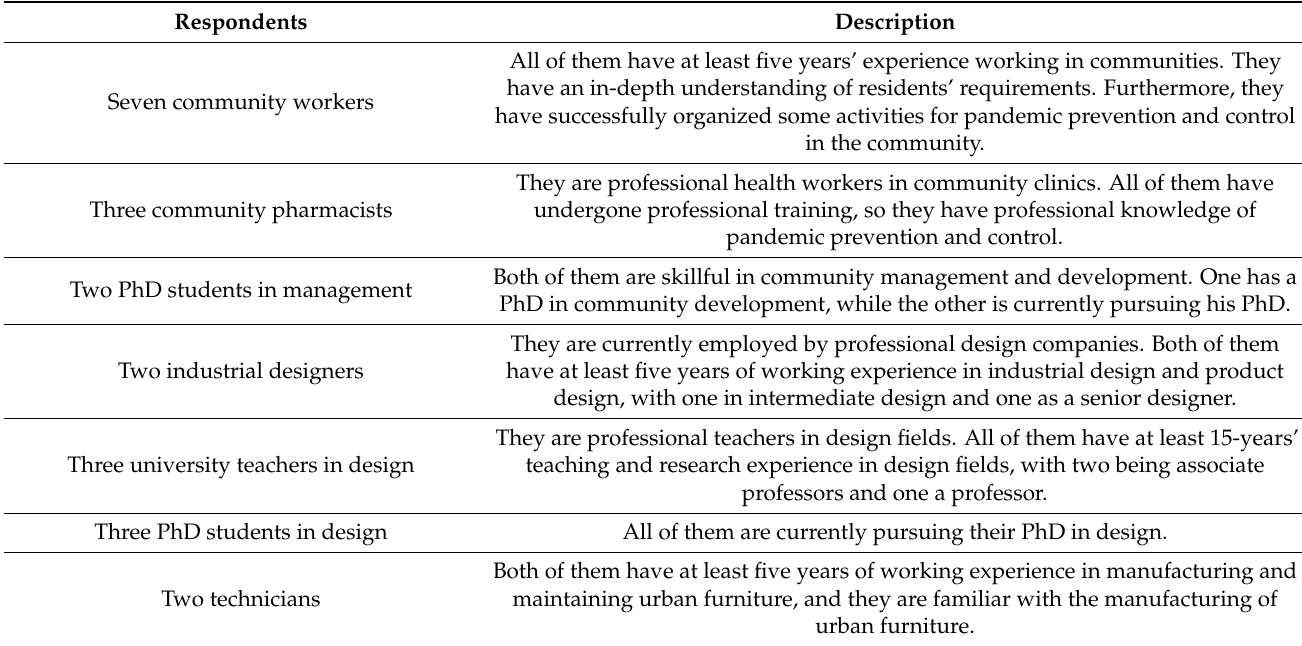
Figure 5. The distribution of eight selected communities on Xinglin Street.